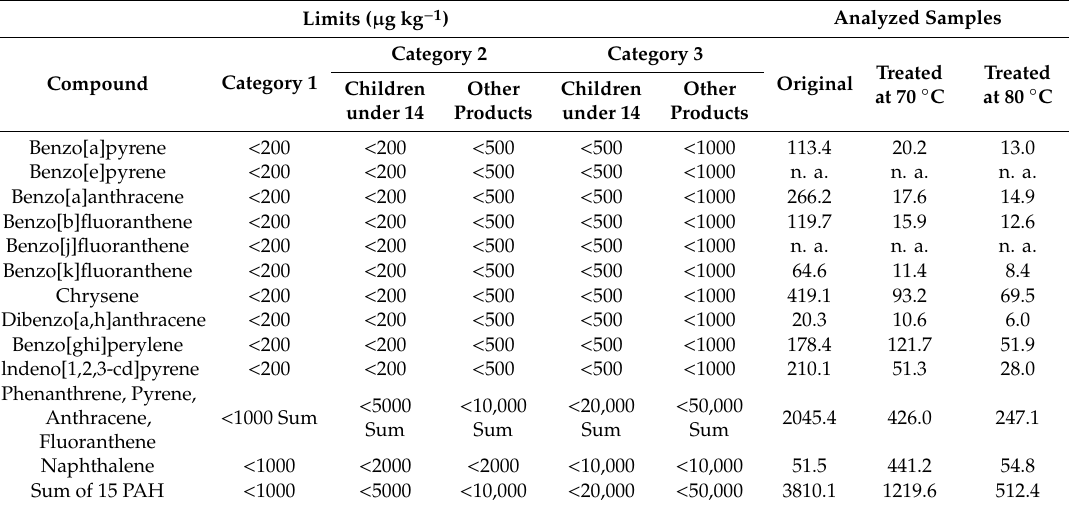
Table 1. Maximum levels of PAHs allowed by the German Product Safety Committee [18].